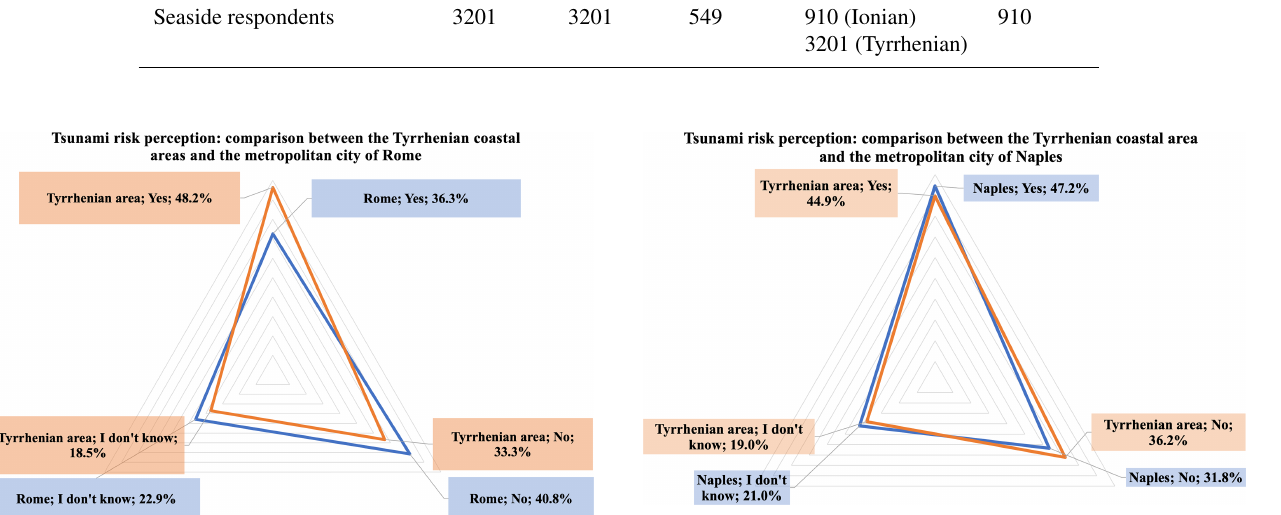
Figure 7. Tsunami risk perception: comparison between the Tyrrhe- nian coastal area and the metropolitan city of Rome. (Q16 – Do you think that the coast of your municipality could be hit by a tsunami?)